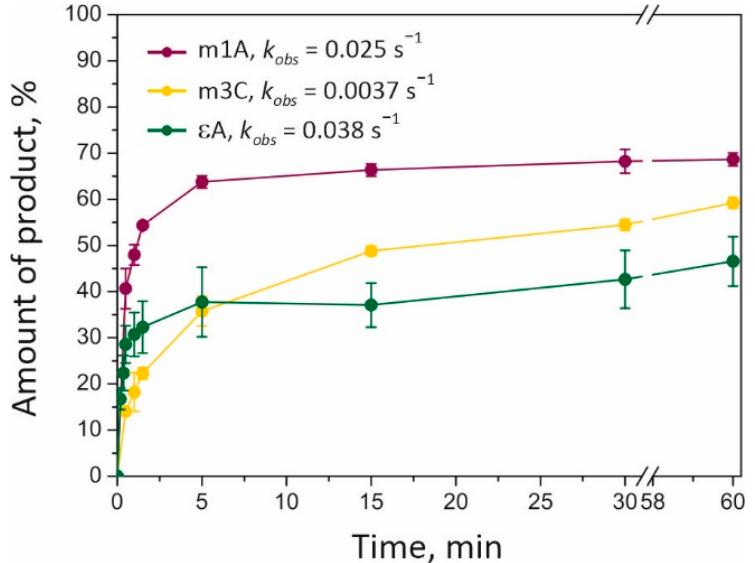
Figure 4. ALKBH2-catalyzed repair of m1A-, m3C-, and ε A-containing dsODNs. Time courses of the dealkylated-product accumulation were obtained at 25 °C by mixing of 2 μ M enzyme with 2 μ M FAM-labeled dsDNA substrate dissolved in reaction buffer containing 40 μ M Fe (II) and 1 mM 2OG (see Section 4). Each reaction time point is the mean ± SD of three technical replicates.